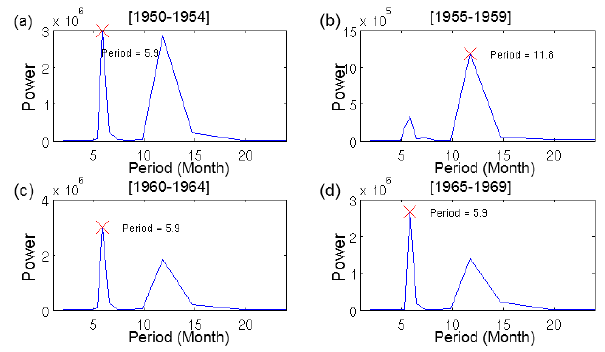
Fig. 23. Periodicities around 1960 in Kisumu estimated from the representative time series of the harmonics. (a) shows the periodic- ities between 1950 and 1954, (b) between 1955 and 1959, (c) be- tween 1960 and 1964, and (d) between 1965 and 1969. The red cross mark means the major periodicity in each time region.